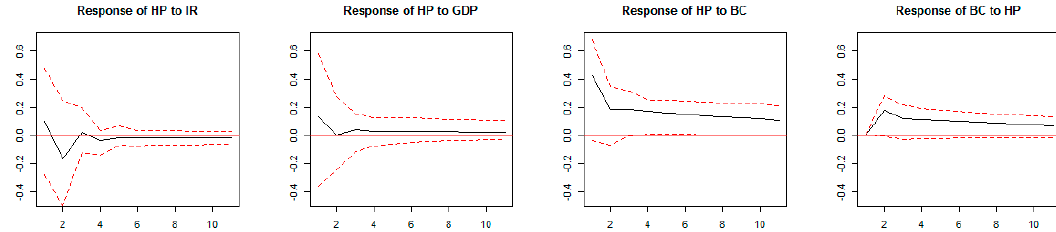
Figure 4. Impulse response based on the standard TVP model for IR, GDP BC, and HP. Notes: This shows the impulse response based on the standard VAR model for the variable set (IR, GDP, BC, HP); the solid line refers to the posterior mean, and the dotted line refers to 95% credible intervals.